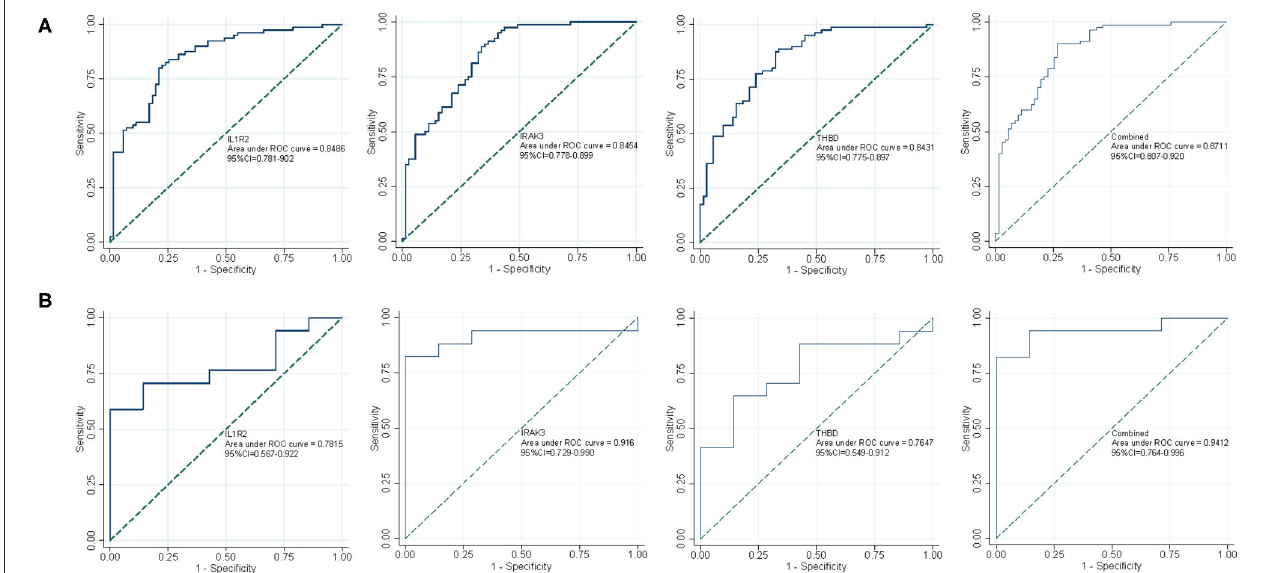
FIGURE 5 | The receiver operating characteristic (ROC) curve of the diagnostic effectiveness of the three diagnostic markers. (A) ROC curve of IL1R2, IRAK3, and THBD after fitting to one variable in the metadata cohort; (B) ROC curve of IL1R2, IRAK3, and THBD after fitting to one variable in the GSE60993